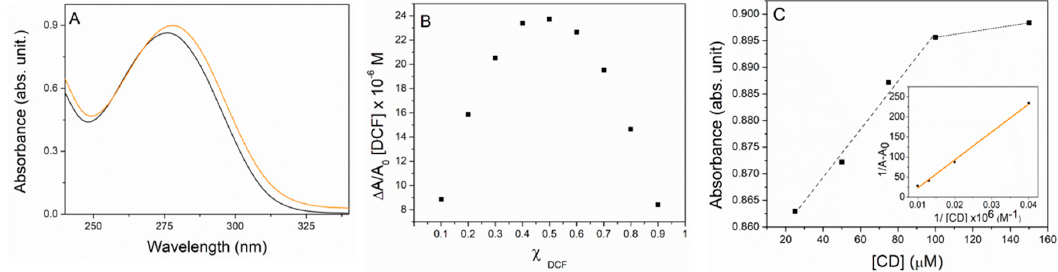
Figure 2. ( A ) UV / Vis spectra of free DCF (black trace) and PolyCD / DCF (orange trace) in water, Figure 2. ( A ) UV/Vis spectra of free DCF (black trace) and PolyCD/DCF (orange trace) in water, [CD] [CD] = [DCF] = 100 µ M; ( B ) Job’s plot for the complexation of DCF with PolyCD from UV / Vis = [DCF] = 100 µM; ( B ) Job’s plot for the complexation of DCF with PolyCD from UV/Vis measurements in ultrapure water (see Experimental section); and ( C ) UV / Vis spectral changes of measurements in ultrapure water (see Experimental section); and ( C ) UV/Vis spectral changes of DCF DCF vs. CD concentration (dashed black traces) and plot of (1 / ∆ A) vs. 1 / [CD] (inset, orange trace, vs . CD concentration (dashed black traces) and plot of (1/ Δ A) vs . 1/[CD] (inset, orange trace, R 2 = R 2 = 0.997) in ultrapure water, [DCF] = 100 µ M, [CD] = 25–150 µ M; d = 1 cm; T = 25 ◦ 0.997) in ultrapure water, [DCF] = 100 µM, [CD] = 25–150 µM; d = 1 cm; T = 25 °C.